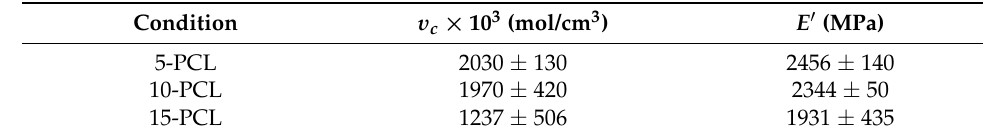
Table 1. Cross-link density (calculated using Equation (4) and glassy storage modulus values (determined at 30 °C) for the different tested conditions.